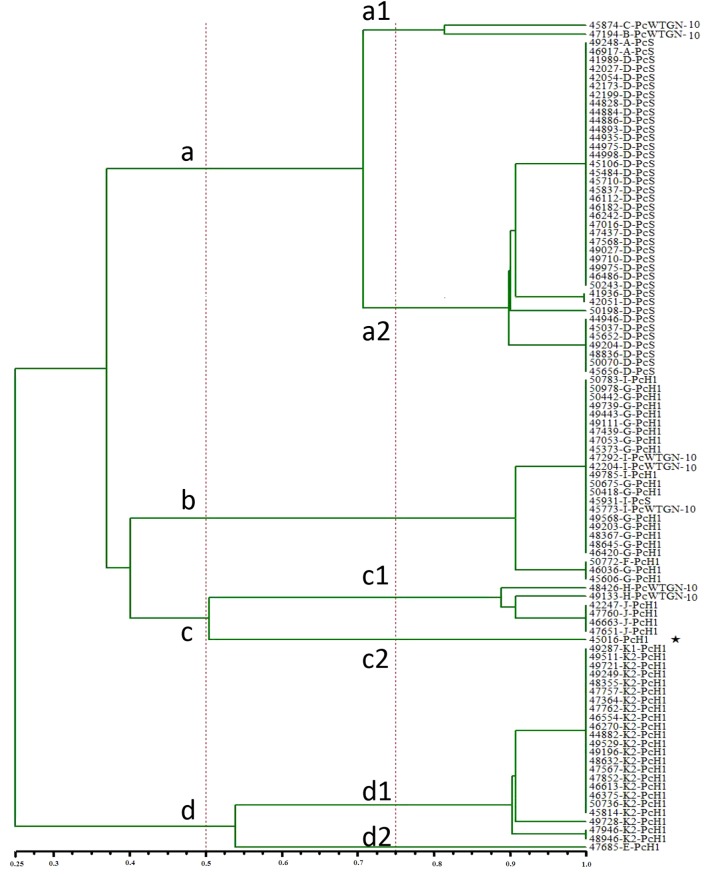
Cluster analysis of 96 strains of Proteus based on ERIC-PCR. (50% homology gathers as a main class, and 75% homology gathers into a subclass, Class 1 integrons for which PCR failed to amplify the gene cassette array).